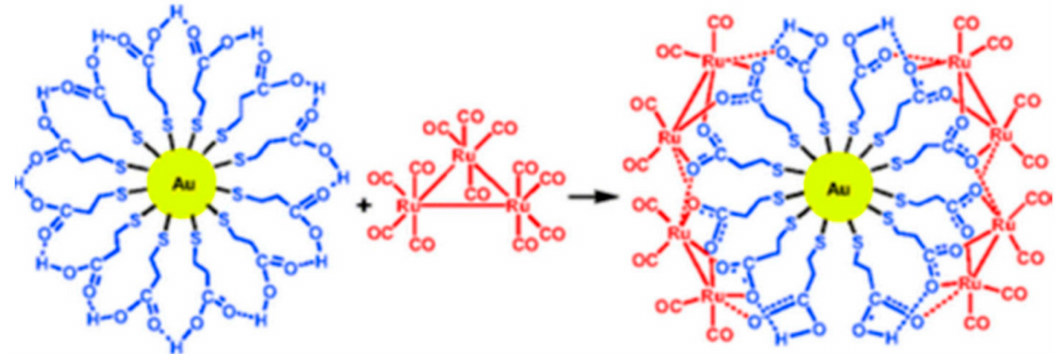
Figure 13. Scheme of Au NPs functioning through trinuclear ruthenium complexes, replicated with reference authoriza- tion [118], ACS,